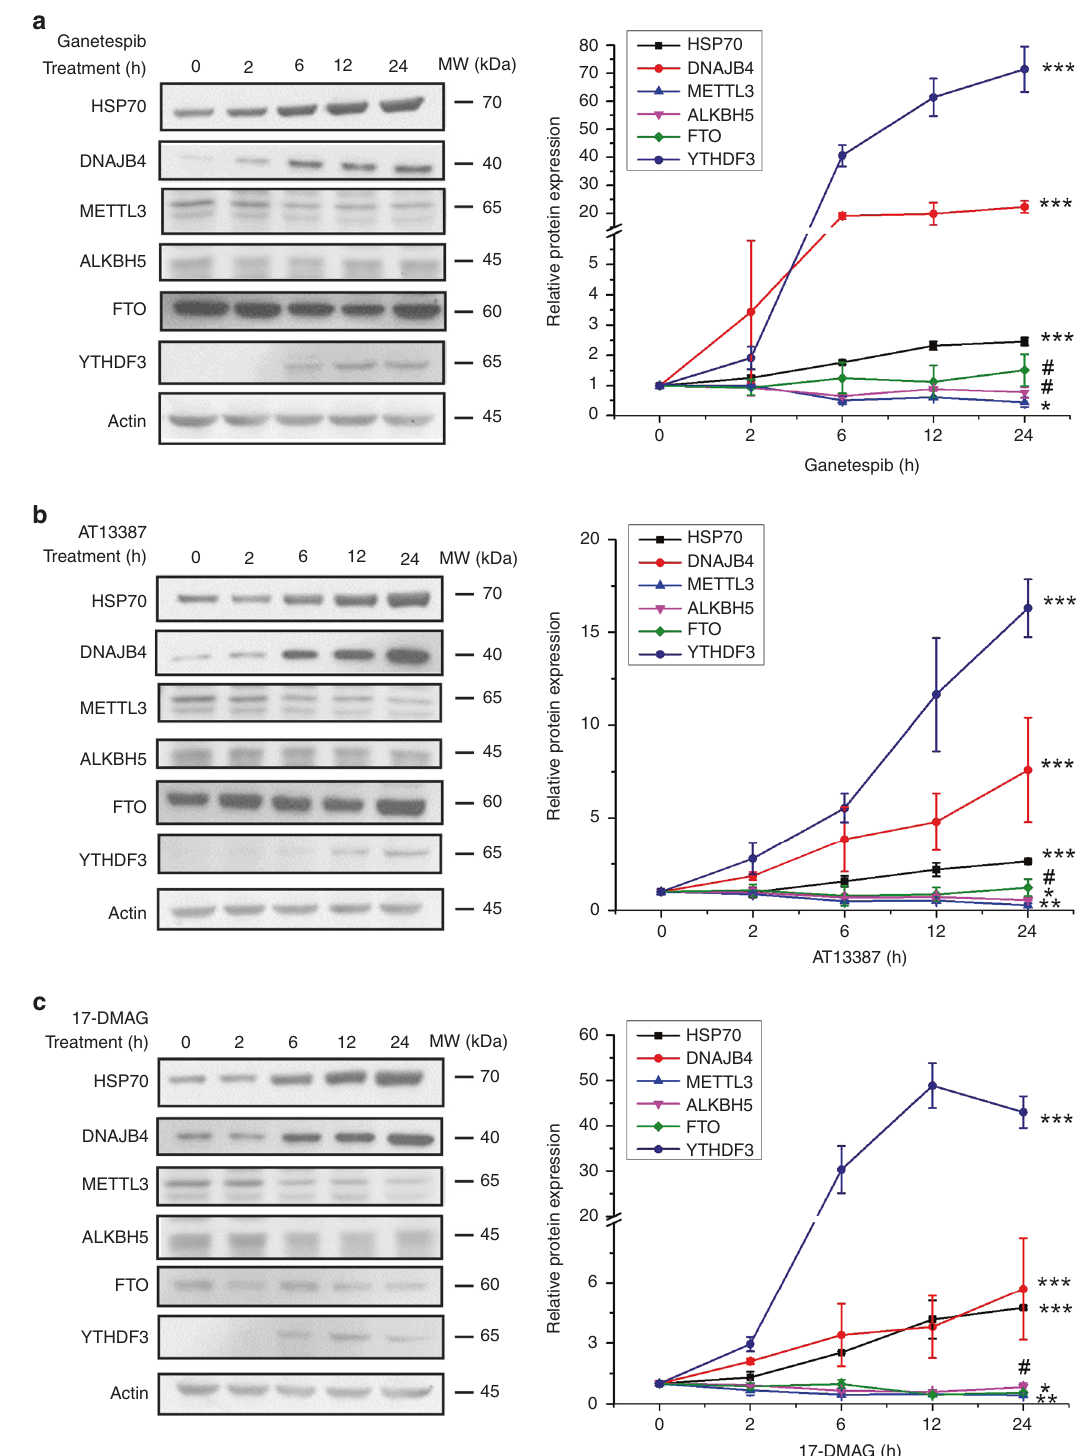
Fig. 3 HSP90 inhibitor-induced temporal changes in protein levels. Western blot images and the quanti fi cation data showing the alterations in expression levels of the HSP70, DNAJB4, METTL3, FTO, ALKBH5, and YTHDF3 in M14 cells at different time points following treatment with 100 nM ganetespib ( a ), AT13387 ( b ), or 17-DMAG ( c ). Shown are the ratios of expression of the indicated proteins over β -actin, and further normalized to the ratios obtained for the control cells without HSP90 inhibitor treatment. The data represent the mean ± S.D. of results from three independent experiments. The p -values referred to the comparison between 0 h and 24 h treatment and were calculated using unpaired, two-tailed Student ’ s t -test: # p > 0.05; *, 0.01 ≤ p < 0.05; **, 0.001 ≤ p < 0.01; ***, p < 0.001. Source data are provided as a Source Data fi